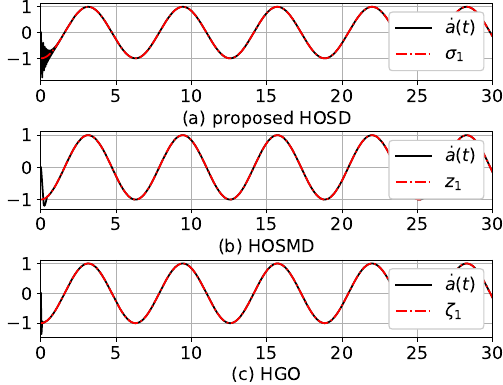
Figure 4. Estimations of ˙ a using parameter set 2 (cid:13) in Table